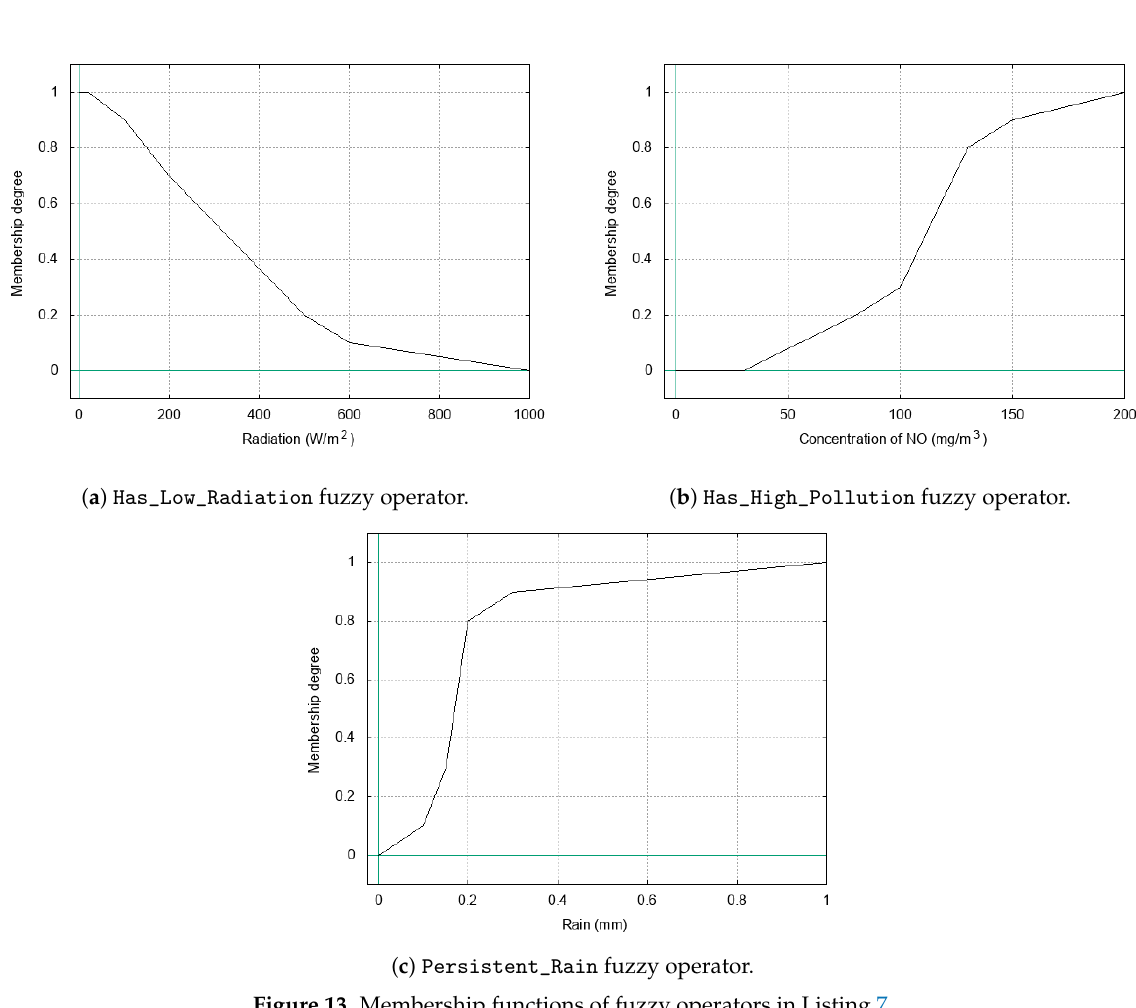
Figure 13. Membership functions of fuzzy operators in Listing